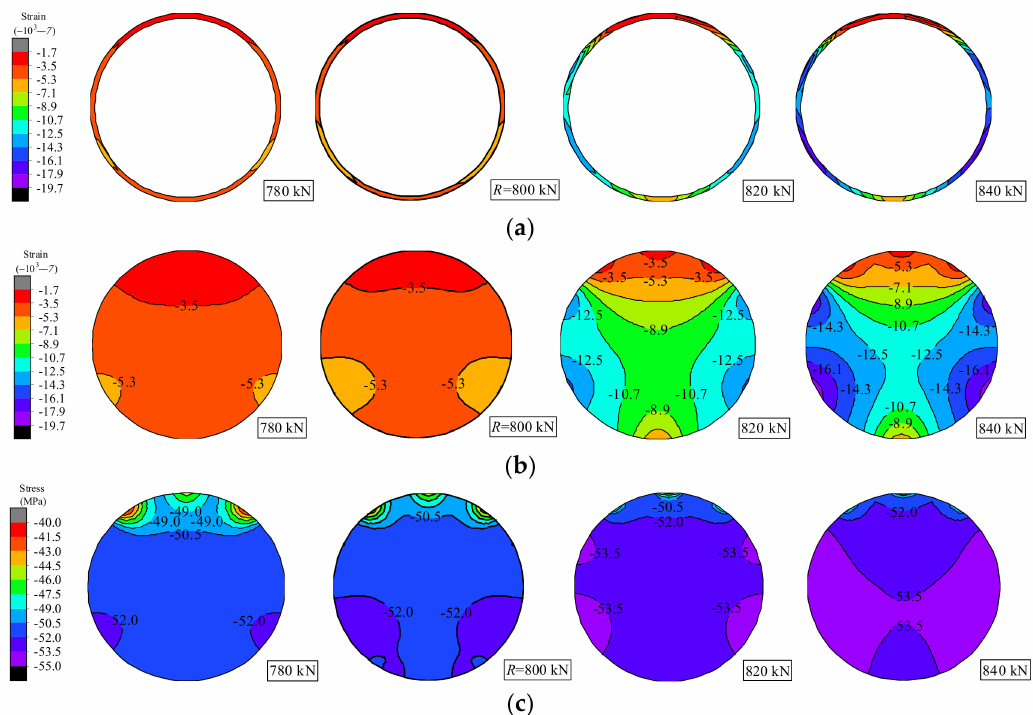
Figure 9. The strain and stress fields of around characteristic load R : ( a ) The strain fields of steel tube around load R ; ( b ) the strain fields of core concrete around load R ; ( c ) the stress fields of steel tube around load R